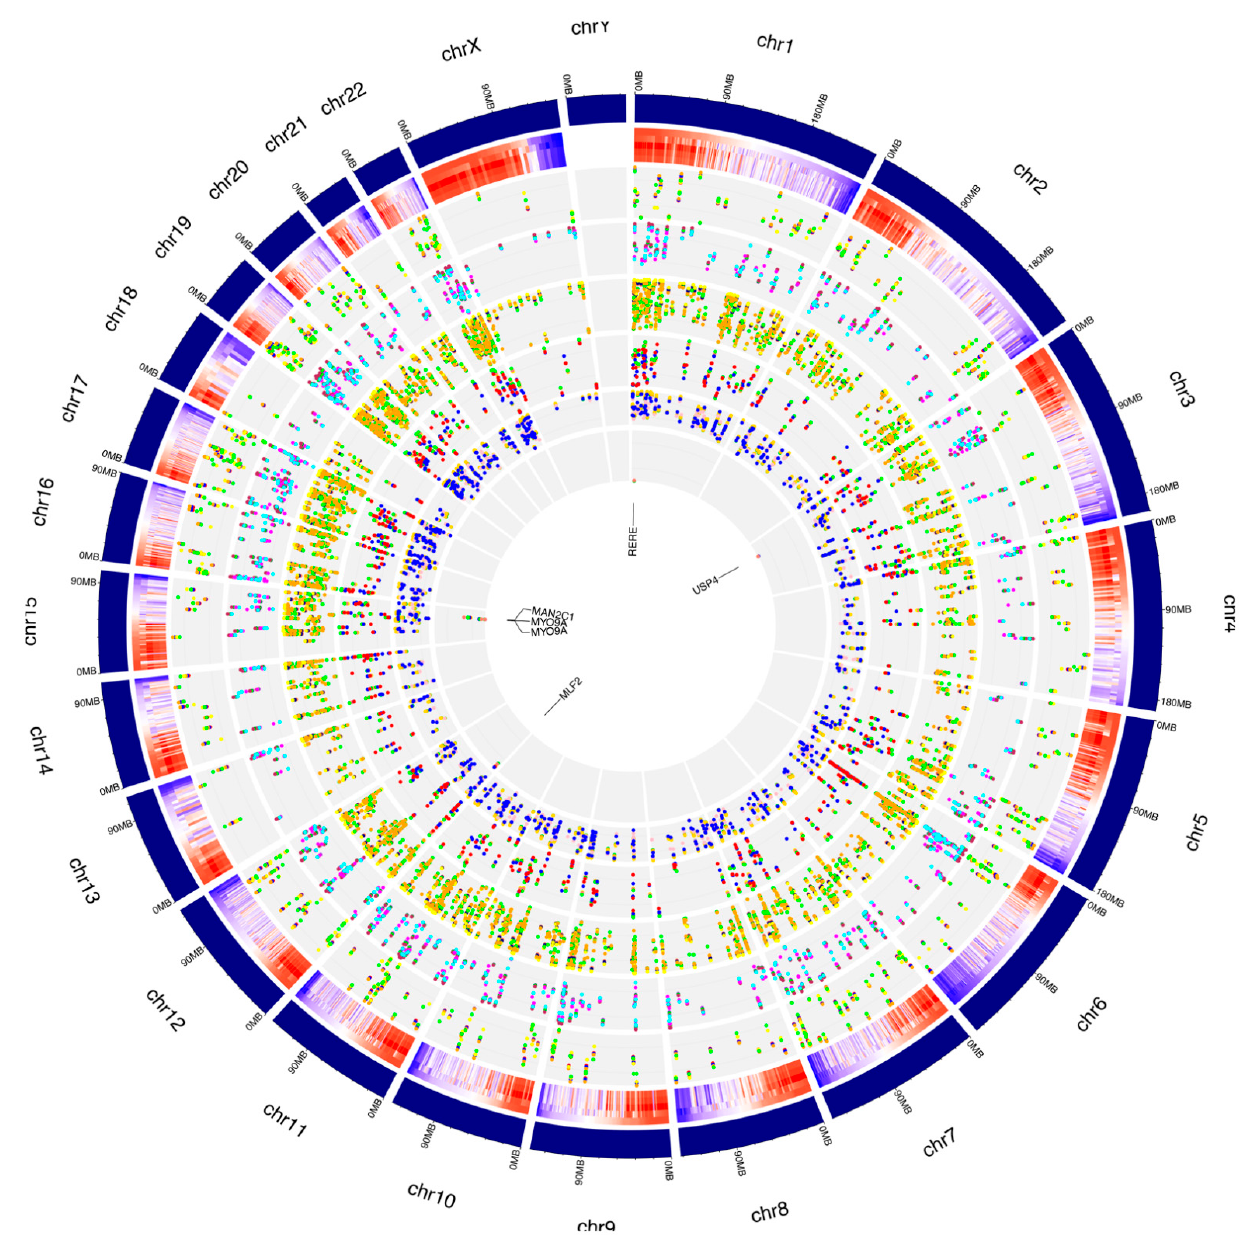
Figure 7. Distribution of de novo RNA editing sites from RPE cells across human chromosomes. The human genome is shown as a circle. For each chromosome, the position of the editing sites along with their average editing ratio (heatmap) is shown for different time points. From outside to inside: (1) N° of A-to-I only editing sites common to all considered time points and controls. The red, blue, orange, yellow and green dots indicate CTRL, 1 h, 2 h, 3 h and 6 h time points, respectively. (2) N° of C-to-U only editing sites common to all considered time points and controls. The purple, green,